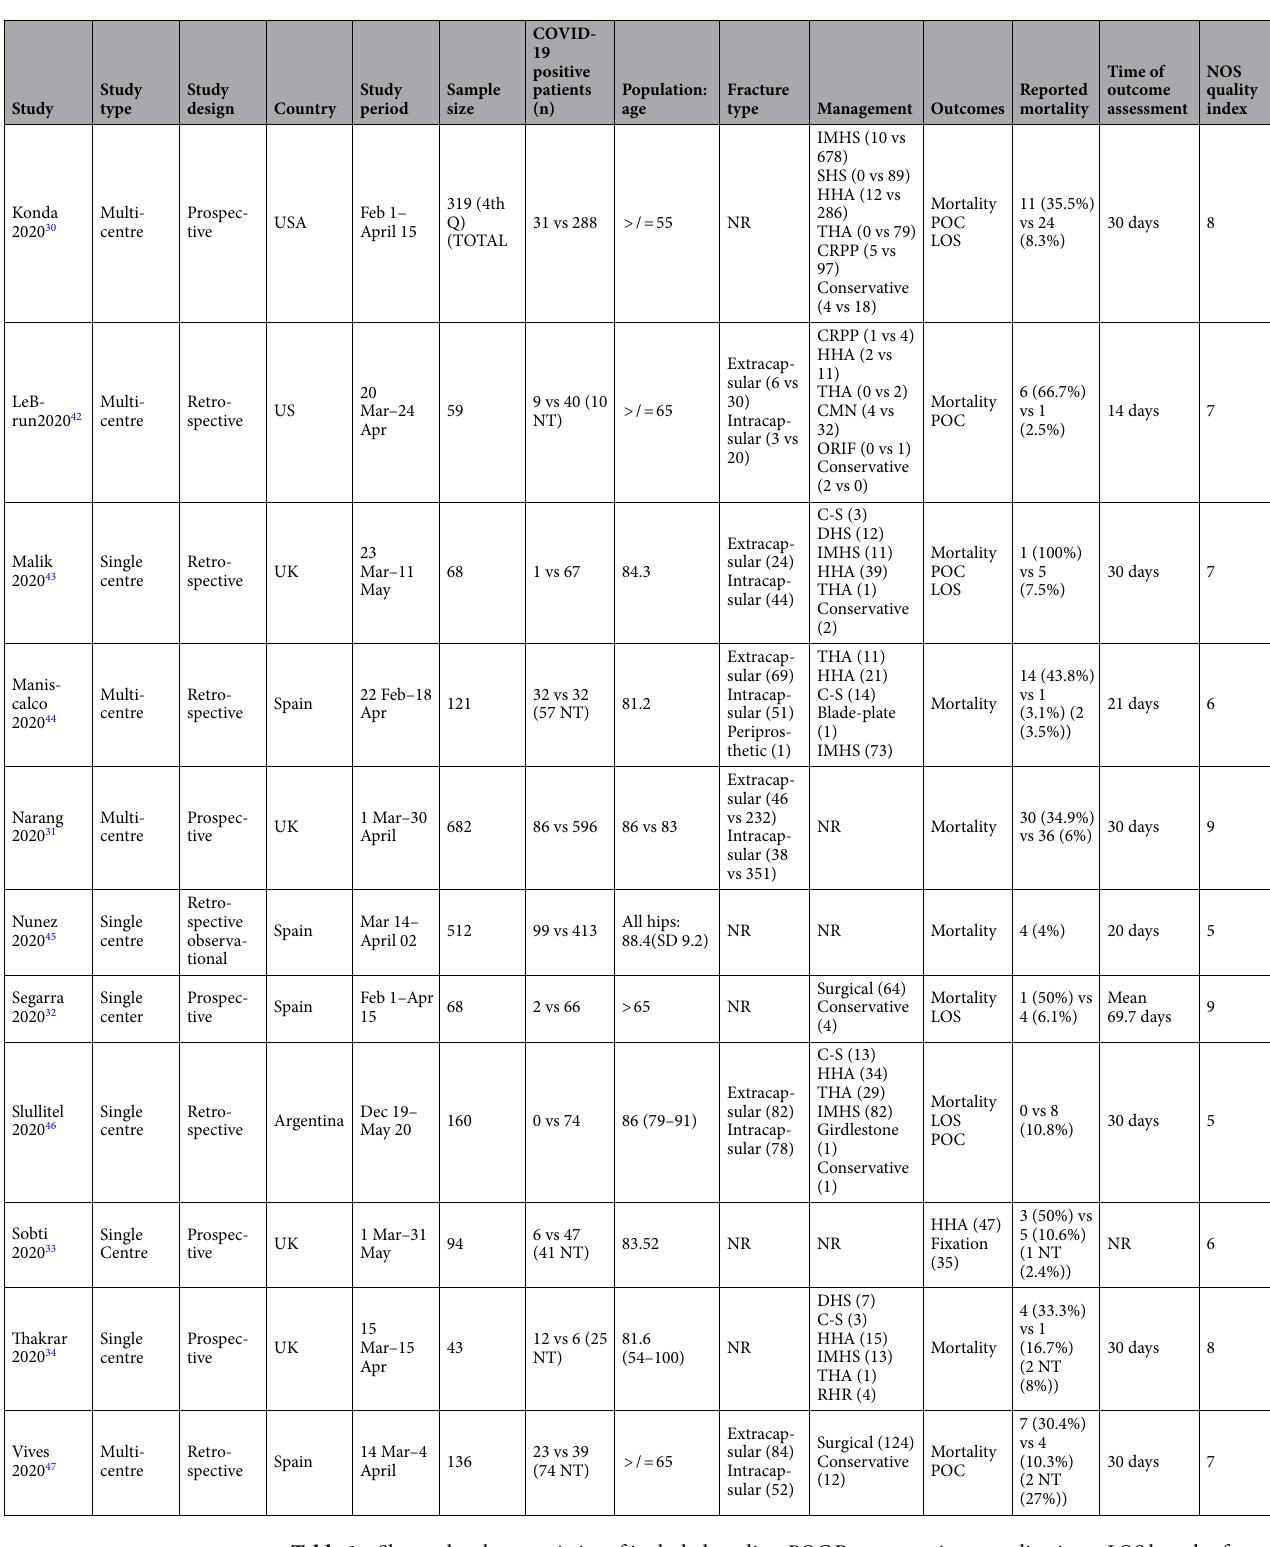
Table 1. Shows the characteristics of included studies. POC Post-operative complications, LOS length of stay, DHS dynamic hip screw, C-S cannulated hip screw, HHA hip hemiarthroplasty, IMHS